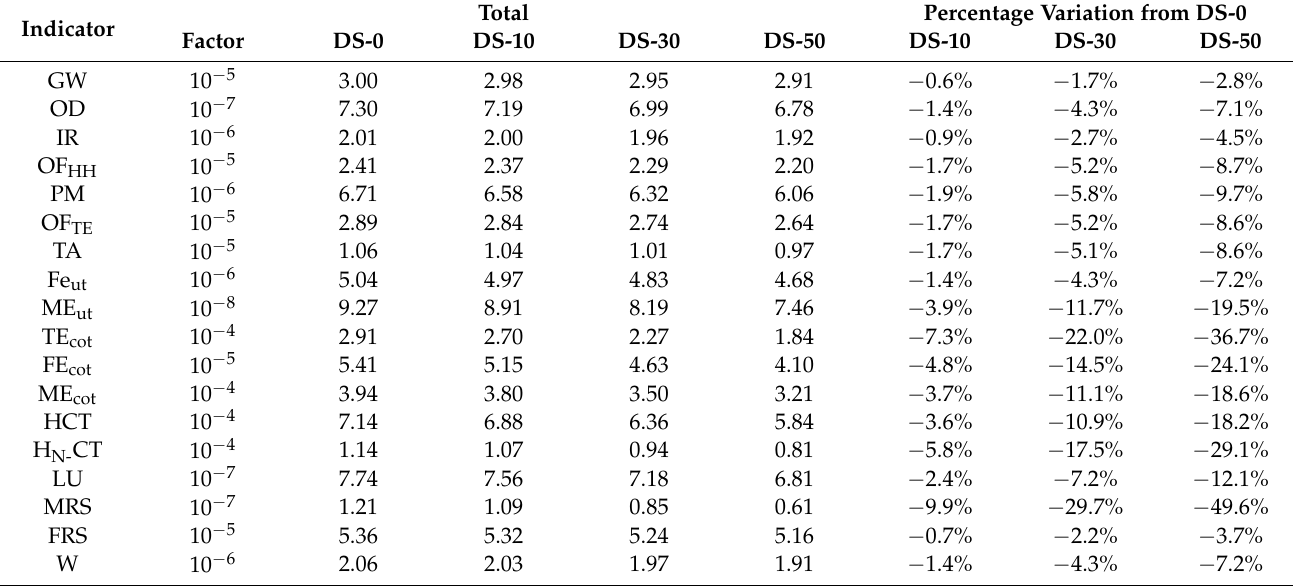
Table 9. Normalized impact categories.